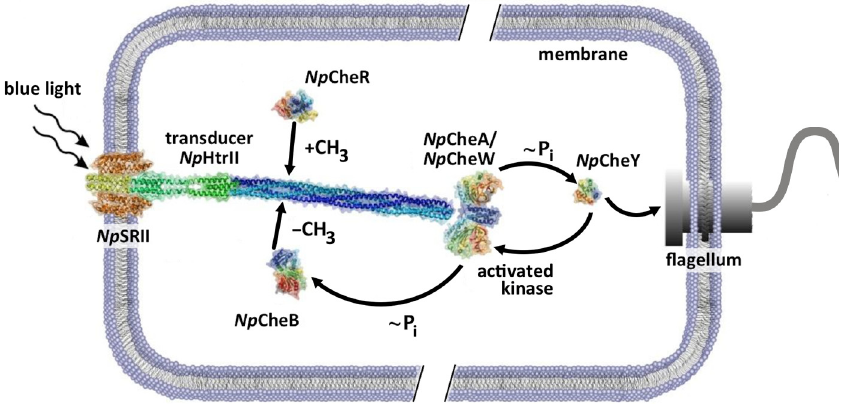
Fig 1. Two component phototaxis system of N . pharaonis . Np SRII/ Np HtrII dimers are the basic elements of photoreceptor complexes in N . pharaonis . They consist of two sensory rhodopsins, Np SRII, and two transducer proteins, Np HtrII, mostly of α -helical secondary structure, with a characteristic domain organization. Light activation of Np SRII induces conformational and/or dynamical changes in the transducer which are converted by two HAMP domains and conveyed along the 20 nm long transducer to the tip region, where it activates the homodimeric histidine kinase CheA bound together with the adapter protein CheW. The kinase CheA undergoes auto-phosphorylation and further transfers the phosphate group to the response regulators CheY or CheB. CheY affects the rotational bias of the flagellar motor, while the methylesterase CheB along with the methyltransferase CheR controls the adaptation (feedback) mechanism. The related chemoreceptor and most likely also the photoreceptor dimers further organize into trimers, which, together with CheA and CheW, lead to the formation of large sensor